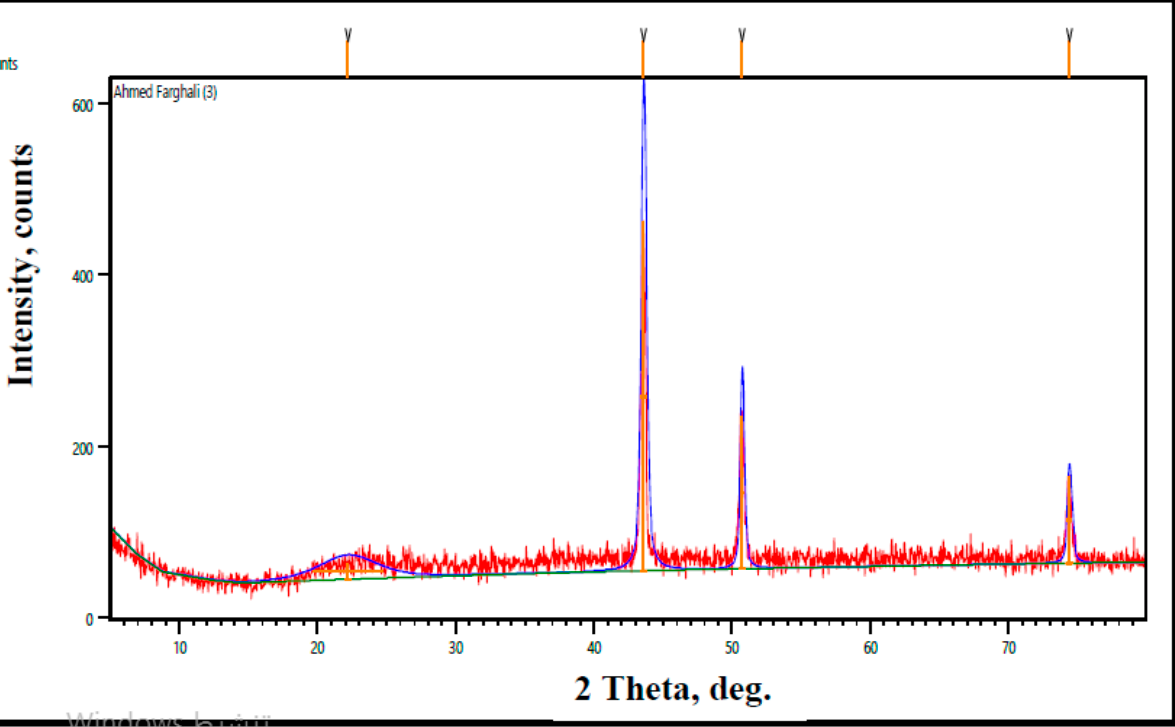
(b) (c) Figure 8. CuO SEM images at ( a ) room temperature, ( b ) 300 °C, and ( c ) 500 °C. SEM images of rGO/CuO composites are shown in Figure 9a–c at various tempera- tures. The images revealed clearly that rGO and CuO stick together, forming stacked bundles and crumpled flakes in agreement with [122–128]. Figure 9a shows that rGO found as wrinkled and scaled sheets porous fluffy network resemblance with spongy-like structure. The CuO nanoparticles randomly distributed on the rGO basal plane in agreement with [129,130]. With a temperature of 300 °C, the scanning electron images of CuO/rGO illustrate a cluster leaf type ofCuO/rGO on which CuO is randomly distribut- ed over the rGO skeleton [131–136]. With the increase in temperature to 500 °C (Figure 9c), the cluster leaf type increased in agglomeration and concentration with CuO that was entrapped and embedded in the rGO, producing identical flake morphology and evenly distributed particles with well-defined morphology [137,138].CuO monoclinic phase